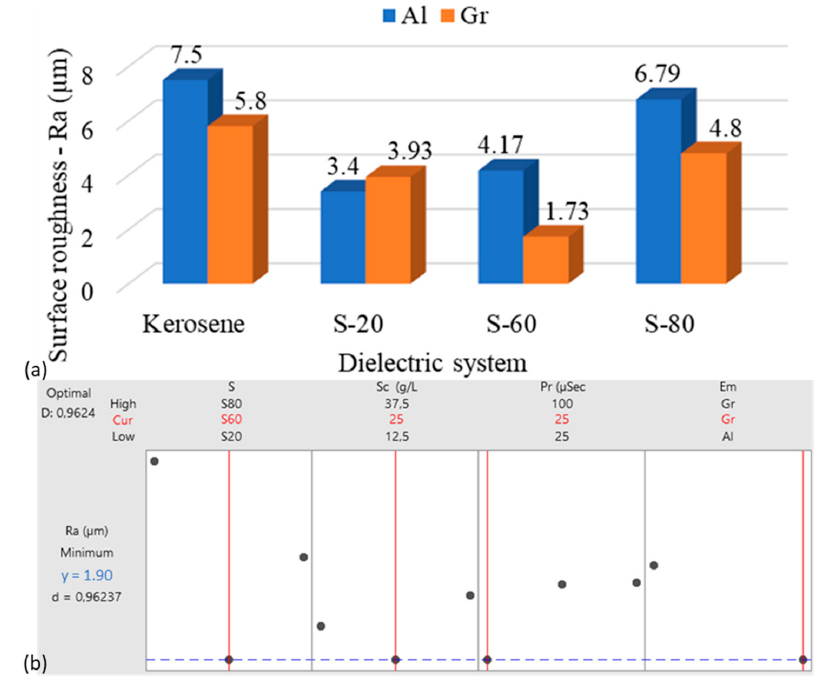
Figure 15. Experimental results of process of the optimization of surface roughness; ( a ) optimized results for each dielectric type; ( b ) optimized results from all variables.